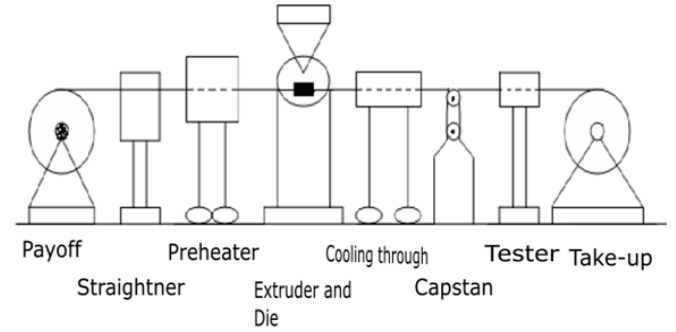
Figure 1. Optical fiber coating process.